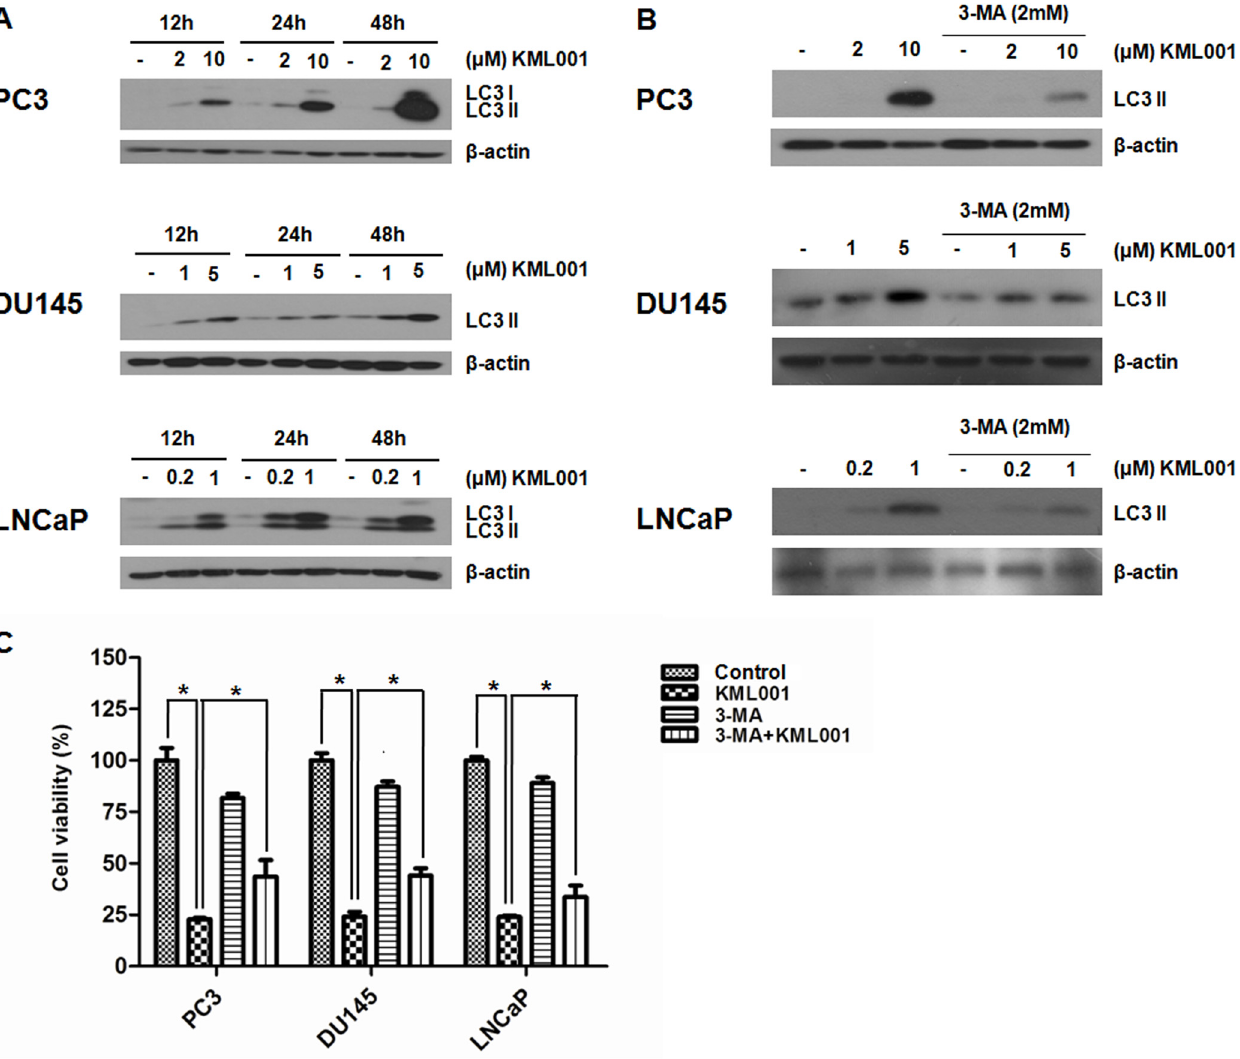
Fig 4. Induction of autophagy by KML001 in prostate cancer cells. (A) Western blot analysis of the time- and dose-dependent conversion of LC3-I to-II. (B) Inhibition by 3-MA of KML001-induced conversion of LC3 in prostate cancer cells. (C) Cells were exposed to 10 μ M (PC3), 5 μ M (DU145), or 2 μ M (LNCaP) KML001 in the presence or absence of 1 mM 3-MA for 72 h. Results were expressed as means ± SD of three independent experiments. * p < 0.05 by one-way ANOVA.